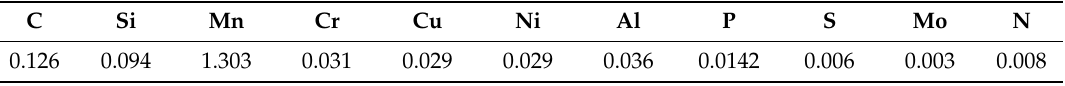
Table 1. Chemical composition with major elements 1 as weight percent of the investigated material.